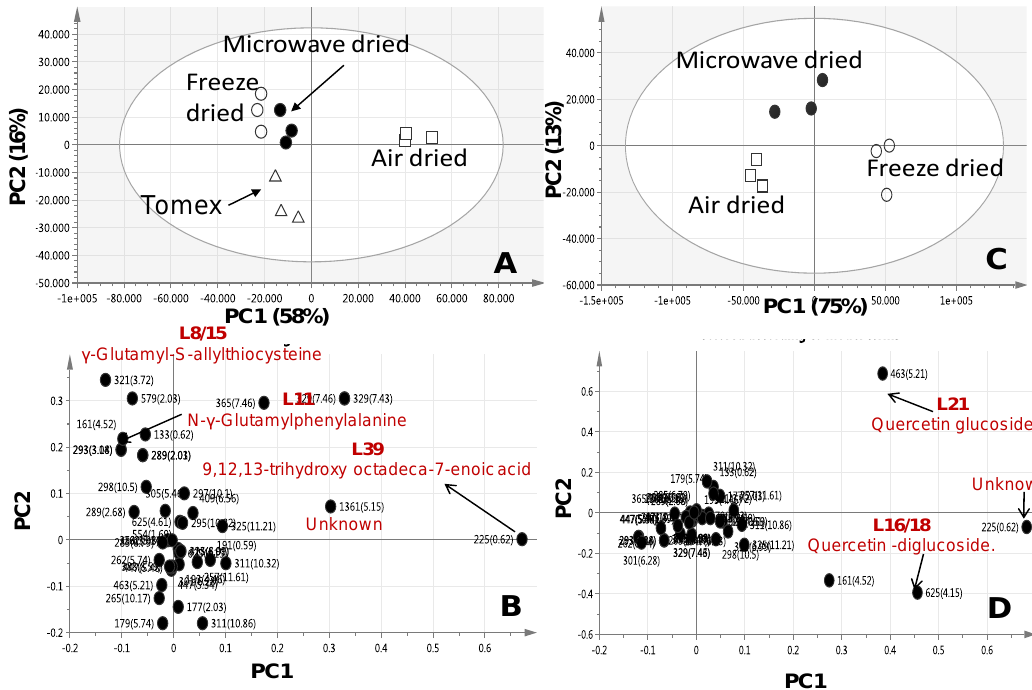
Figure 5. UPLC/MS based PCA score plot derived from modelling A. sativum specimens ( A ) and A. cepa red cv. specimens ( C ) one at a time separately to assess the effect of drying on metabolites composition ( n = 3); The loading plot from A. sativum model ( B ) and A. cepa red cv. specimens ( D ) shows the most variant masses detected using UPLC/MS and contributing to the samples segregation. Metabolites are denoted with m / z /retention time (sec) pair and identifications are discussed in the text.